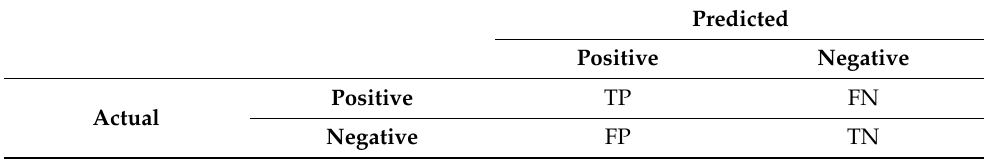
Table 2. Confusion